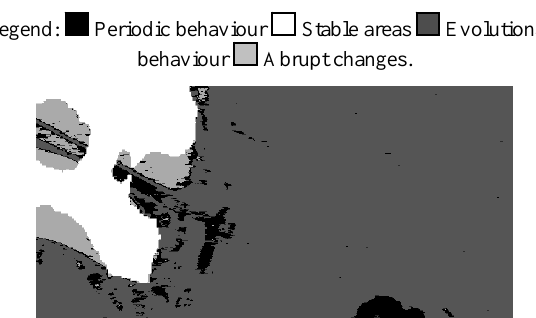
Figure 10. Real data DSMT t emporal Classification